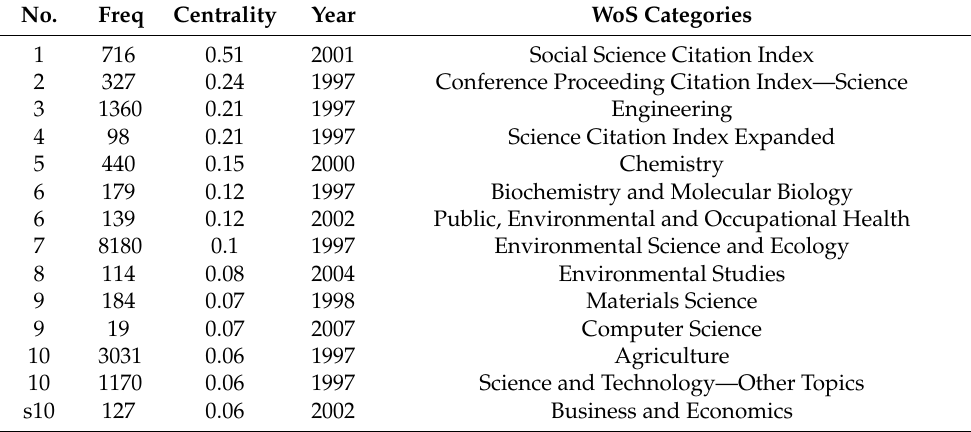
Table 7. List of the most influential